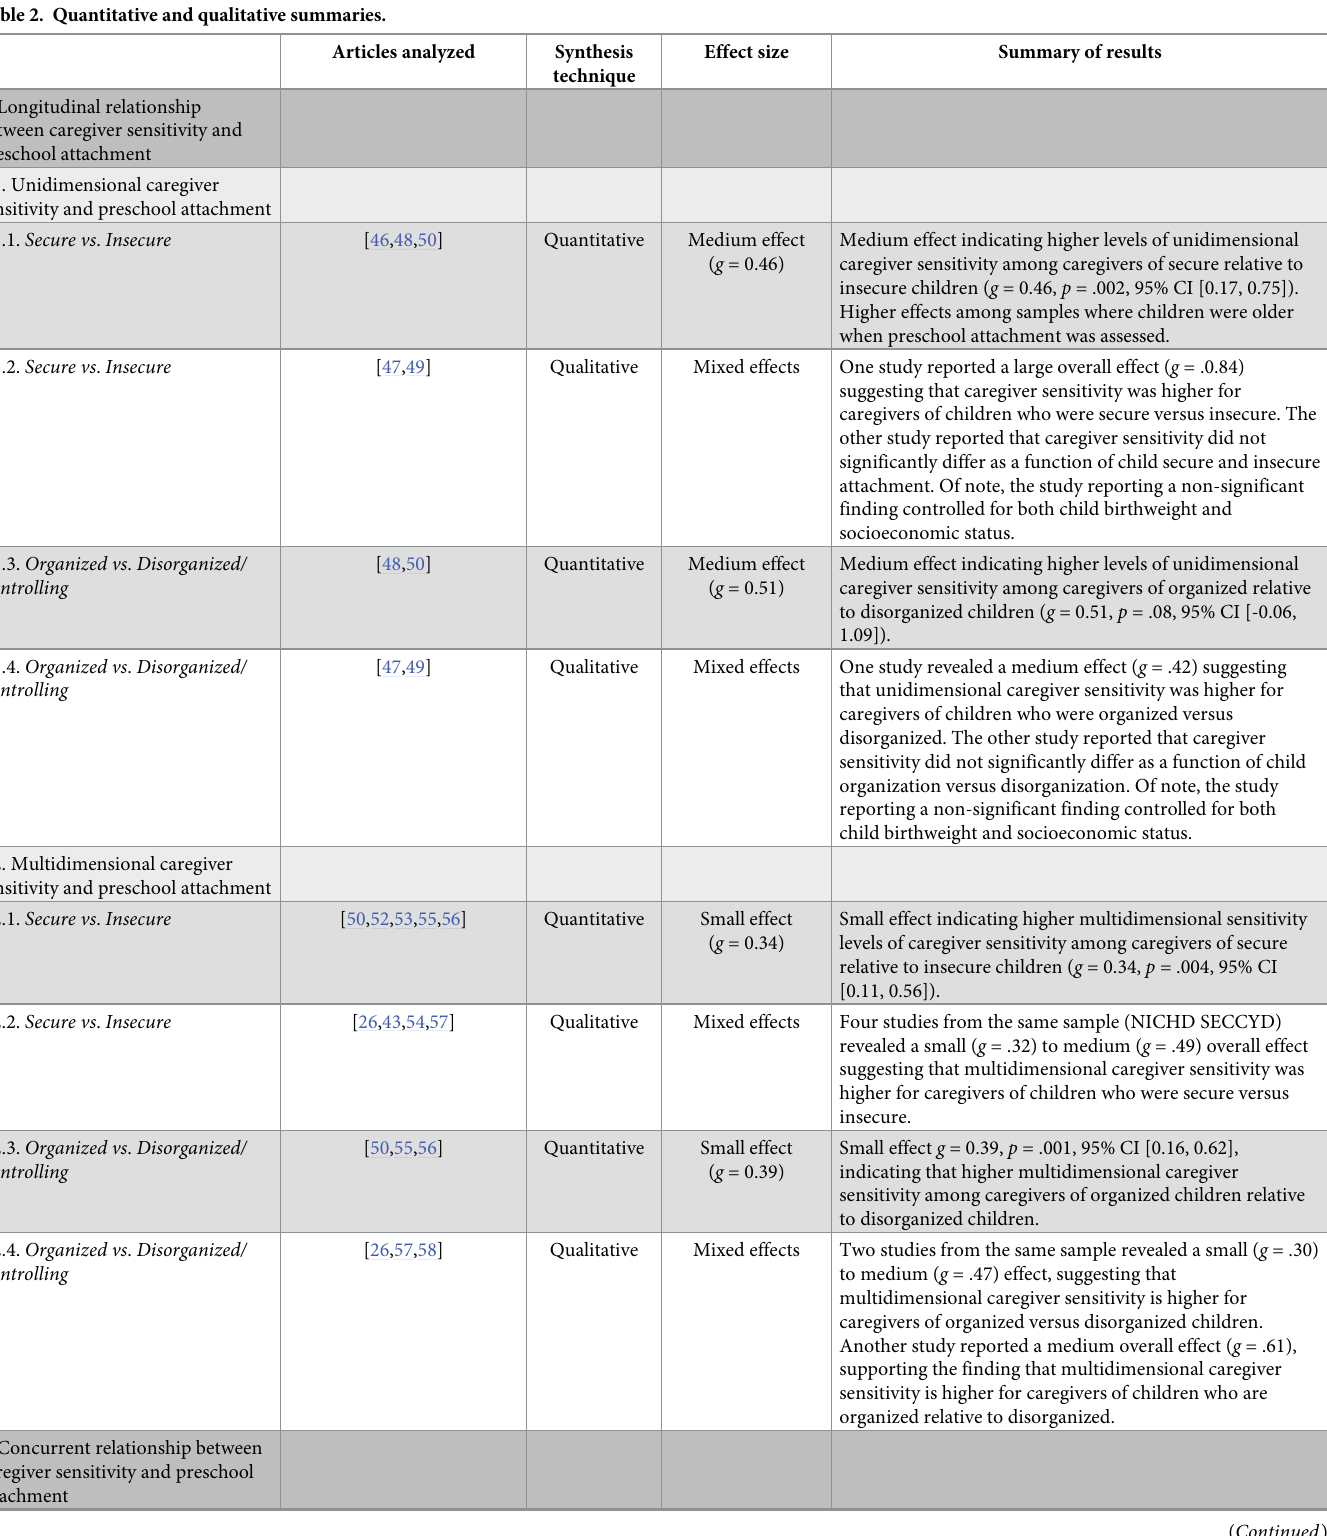
Table 2. Quantitative and qualitative